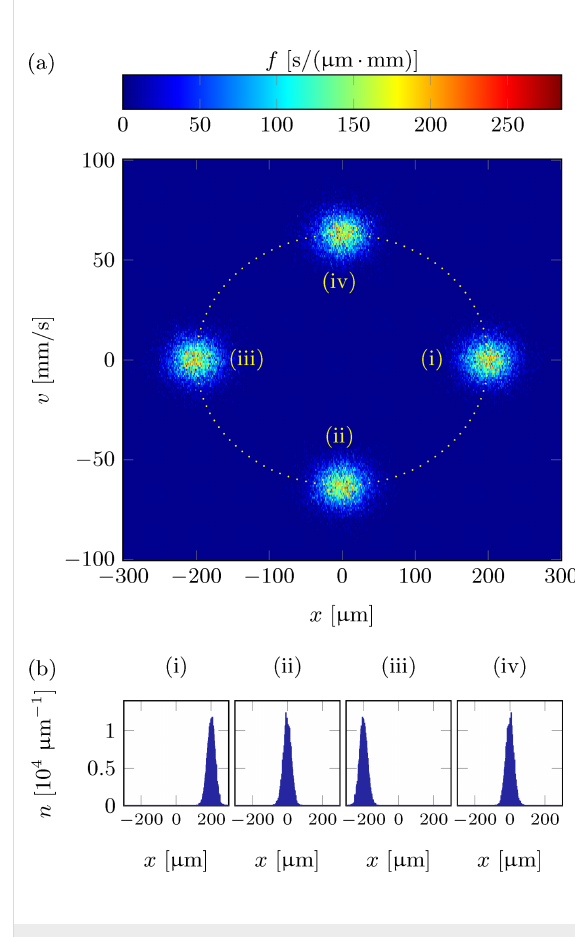
Figure 1: Numerical simulation of an oscillating cold-atom tip in a harmonic potential of fundamental period T = 1/(50 Hz): (a) phase- space density and (b) density profiles at t = 0 T, 2.25 T, 4.5 T, 6.75 T (i–iv) after the initial tip displacement. The simulations do not change if particle collisions are taken into